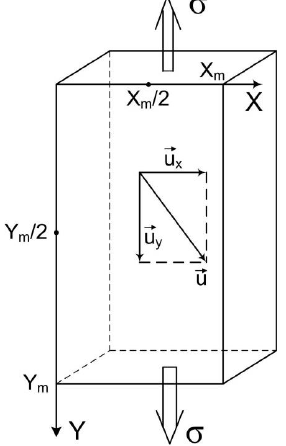
Figure 3. Tensile scheme and coordinate system.